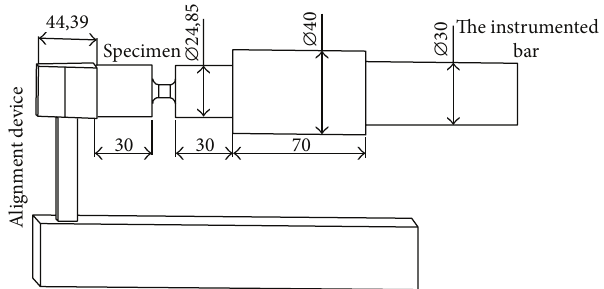
Figure 3: Impact system of the crossbow with the dimensions (in mm) of each